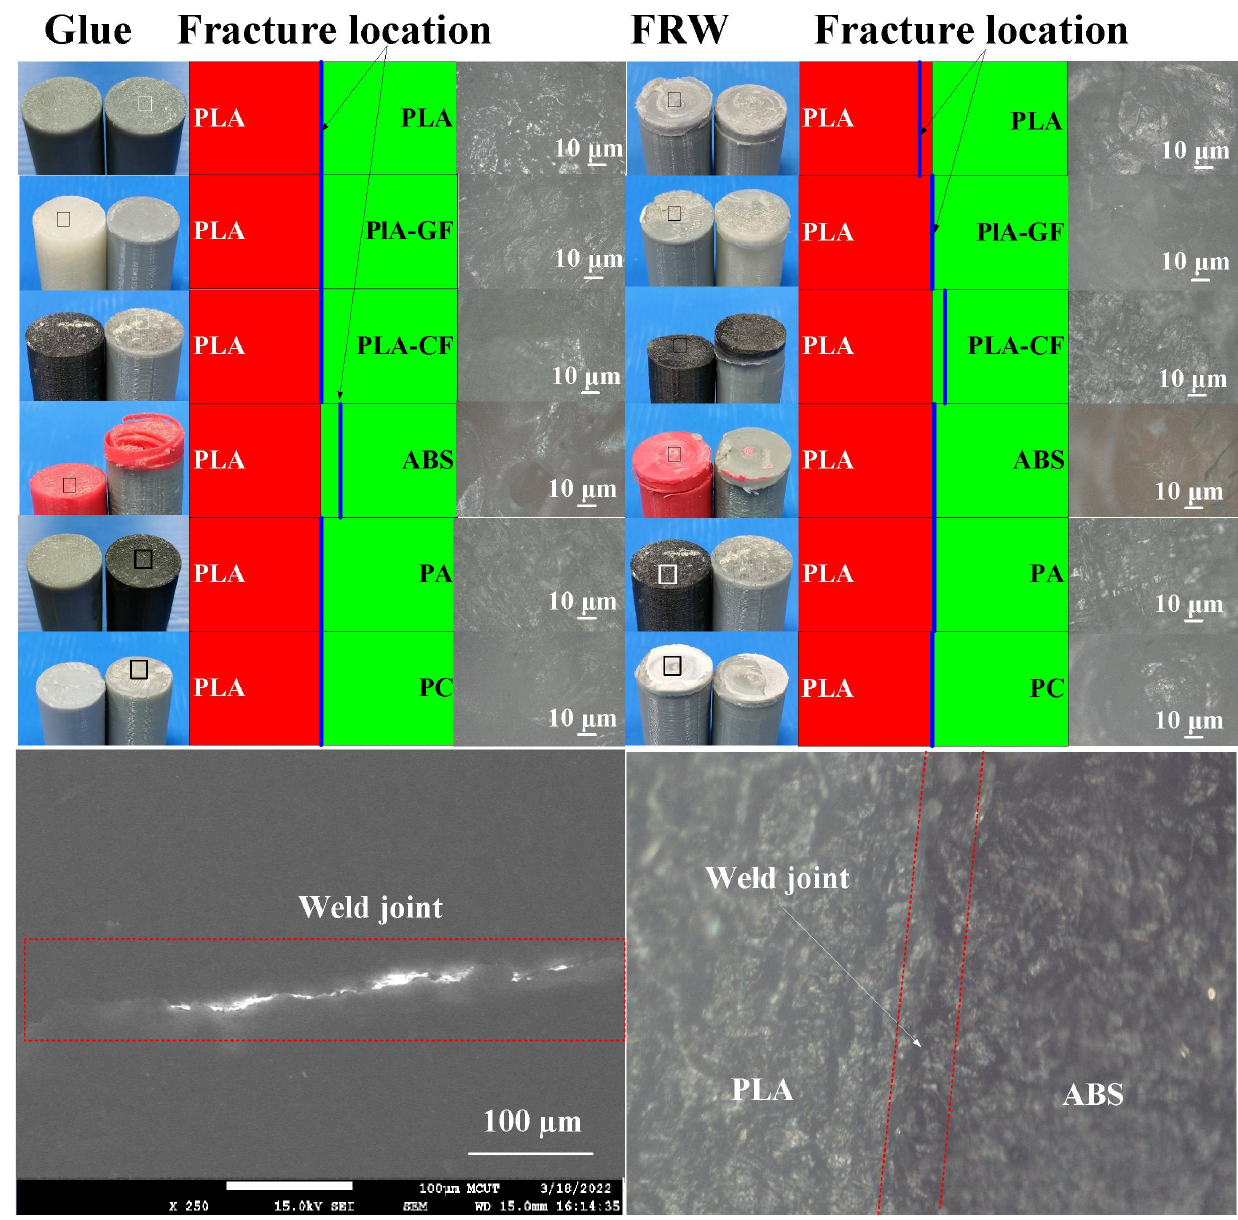
Figure 19. Optical microscopic images of fractured surfaces after impact test.